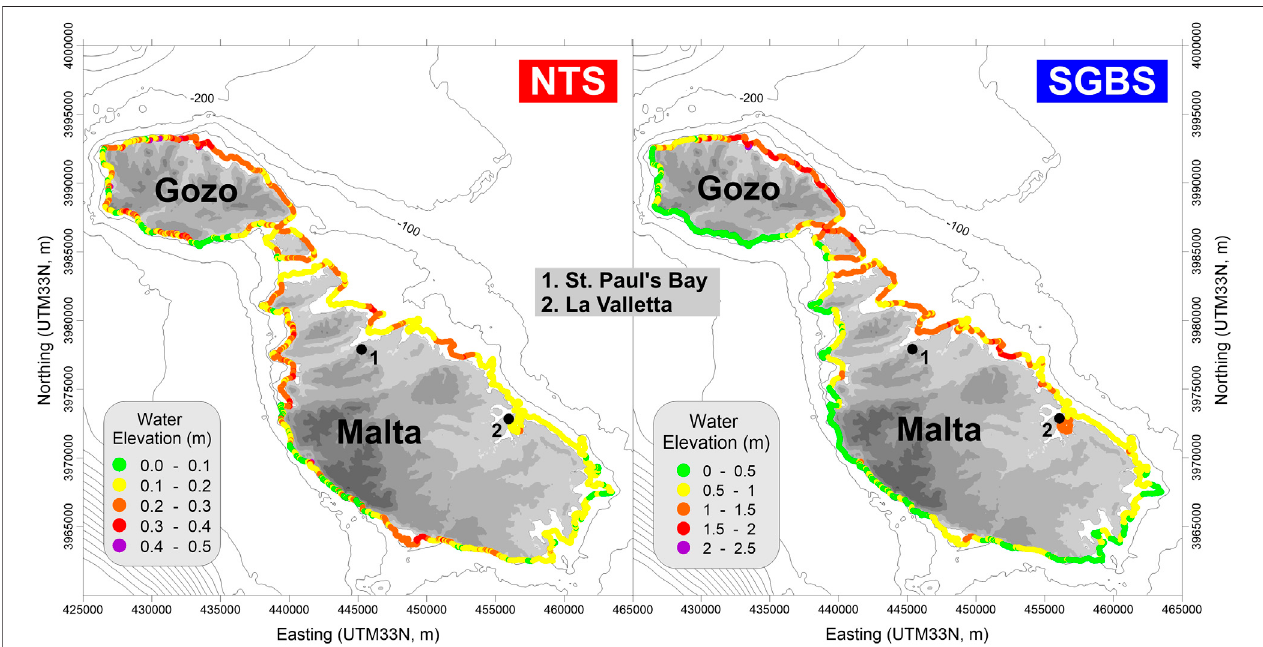
FIGURE 10| Maximum water elevation along the coast of the Malta archipelago, taken on the 20-m isobath, for the two tsunami scenarios: NTS on the left, SGBS on the right. The numbered dots mark the main toponyms. Notice the different range of the color scales used for the two cases.